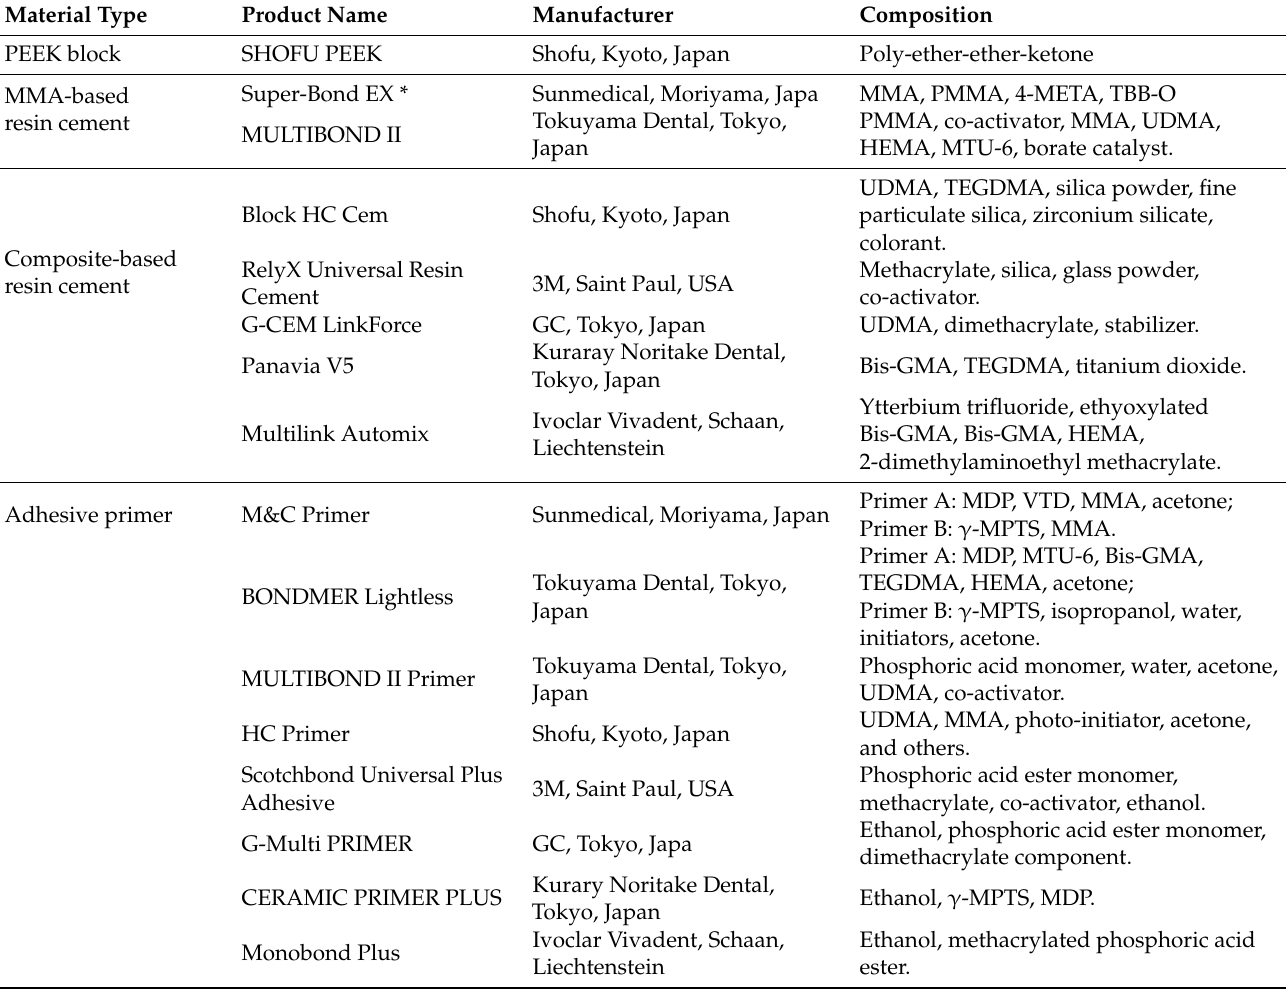
Table 1. Materials used in the current study. The material compositions are based on the information provided by the respective